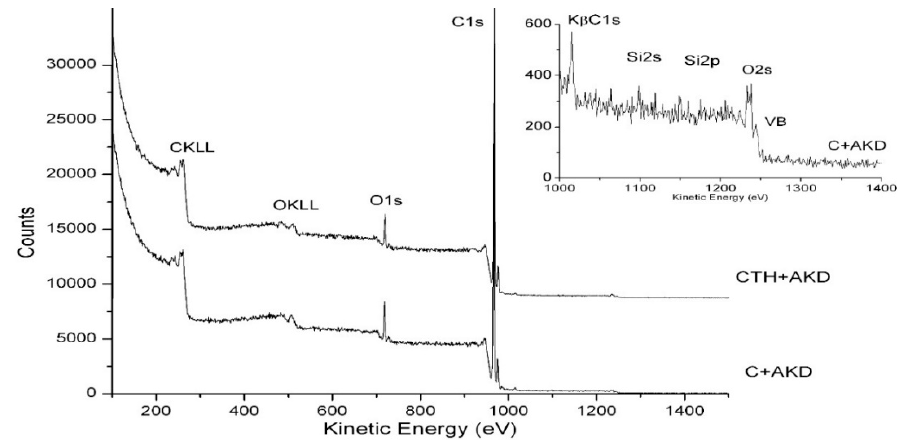
Figure 11. Wide spectrum of thermally modified (CTH + AKD, top ) and unmodified (C + AKD, bottom ) cedar wood samples.